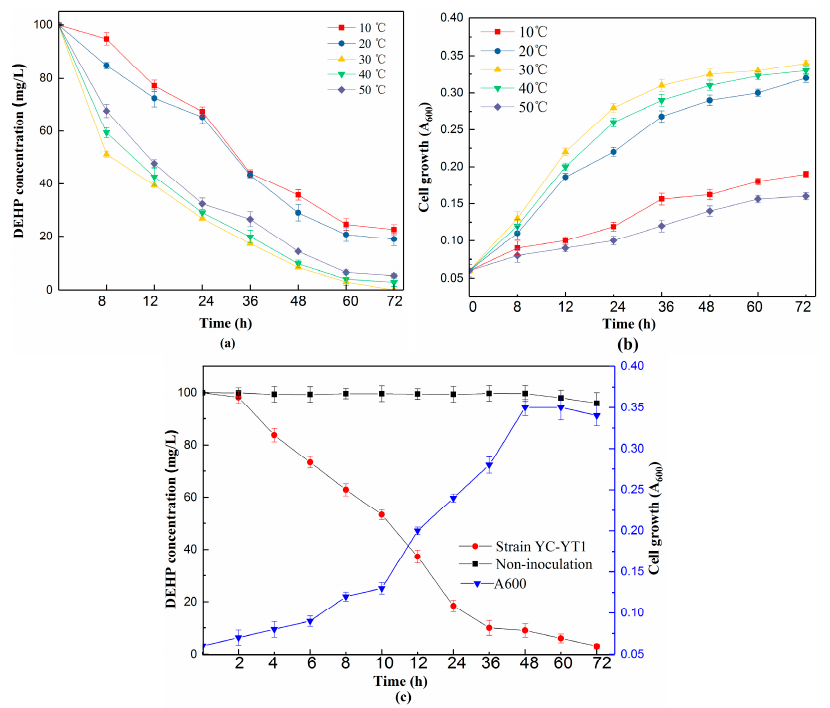
Figure 4. Effects of incubation temperature on the degradation of DEHP and cell growth of strain YC-YT1. ( a ) Effects of incubation temperature on the degradation of DEHP; ( b ) Effects of incubation temperature on the cell growth of strain YC-YT1; and ( c ) DEHP degradation rate and cell growth of strain YC-YT1 under optimized conditions. Error bars indicate standard deviations of the